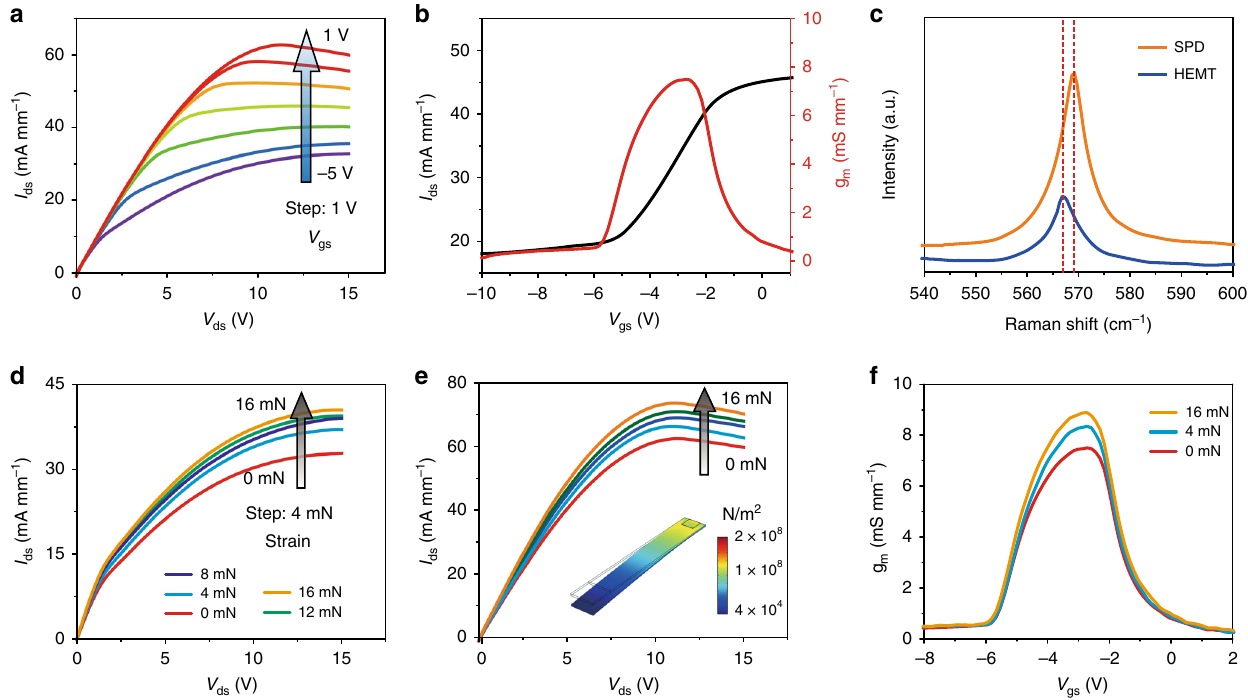
Fig. 3 Electrical performance of the SPD. a Output ( I ds – V ds ) characteristics of the SPD as the V gs ranging from − 5 V to 1 V at a step of 1 V. b Transfer ( I ds – V gs ) characteristics and the transconductance of the SPD measured at V ds = 6 V. c Spatial Raman spectra of the AlGaN/AlN/GaN heterostructures before (HEMT) and after (SPD) dry-etching for the cantilever structure. d , e Output characteristics of the SPD under external strain from 0 – 16 mN, with the gate voltage V gs of ( d ) − 5 V and ( e ) 1 V, respectively. The inset of ( e ) illustrates the strain distribution of the SPD under an external strain of 16 mN, which is simulated by COMSOL Multiphysics. f The transconductance characteristics of the SPD under various external strain (0 mN, 4 mN, and 16